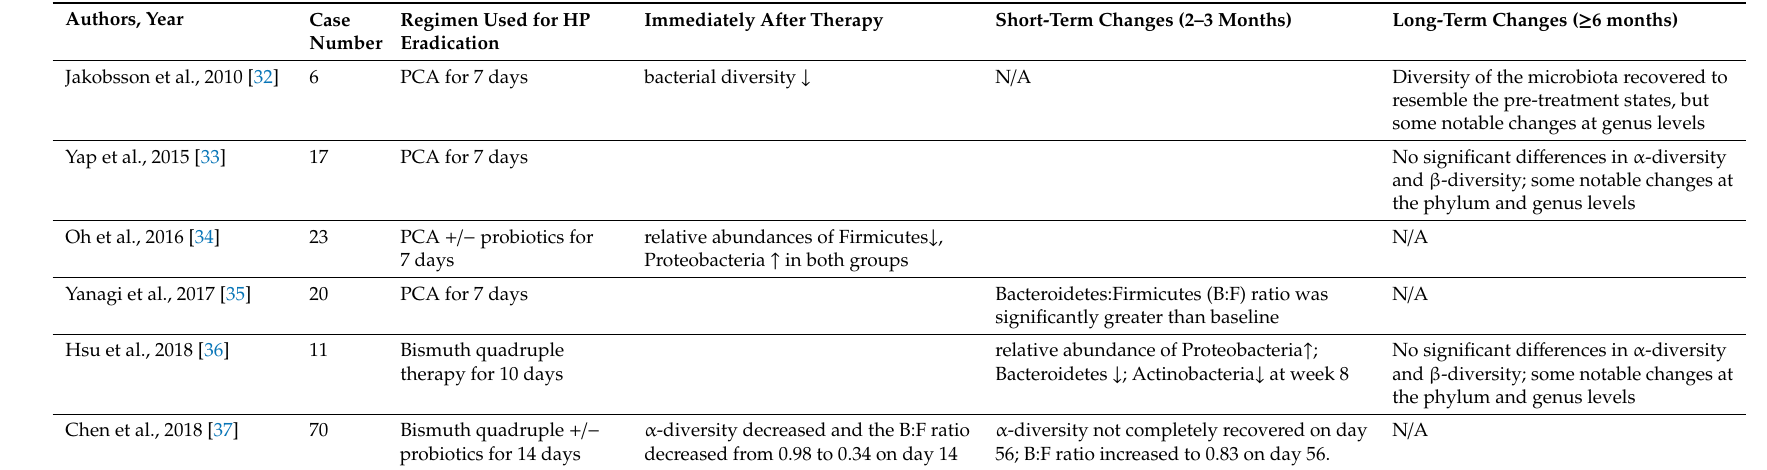
Table 4. The impact of H. pylori eradication therapy on the gut microbiota (sequencing of 16S